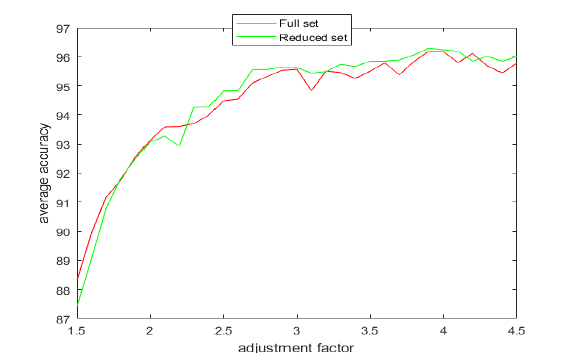
Figure 10. The average accuracy versus the adjustment factor for the full and the reduced Wine dataset.